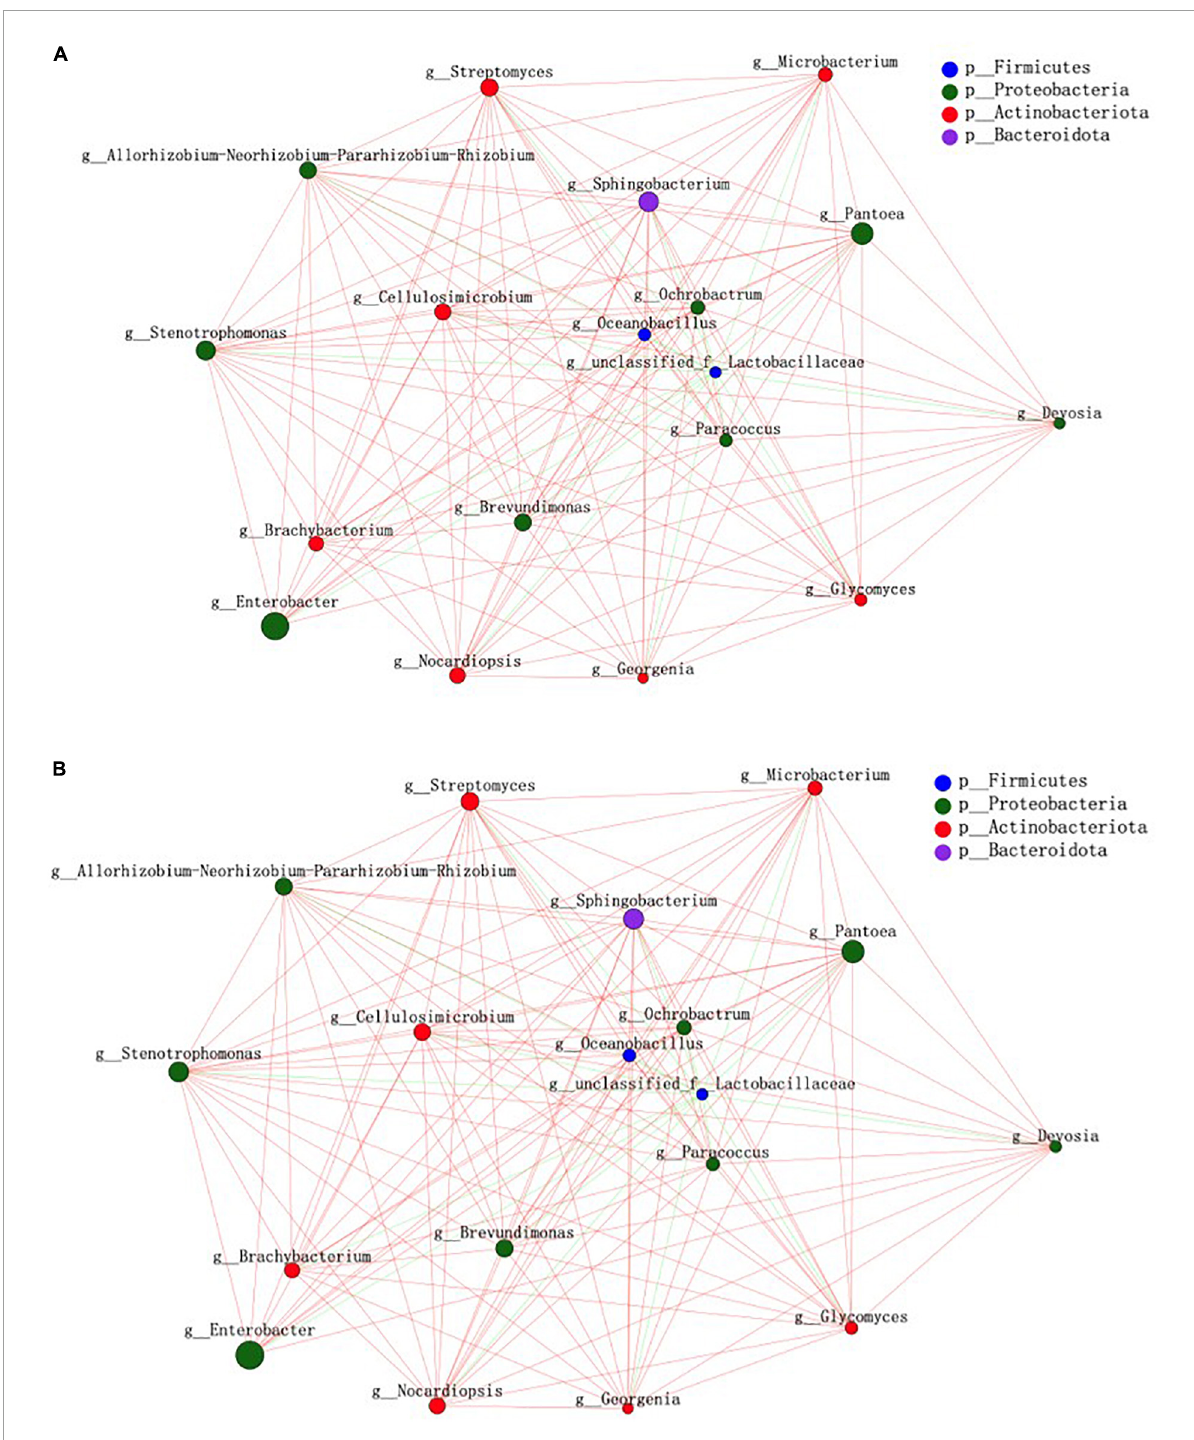
FIGURE2 Bacterial community structure in sainfoin silage. (A) Bacterial network analysis of sainfoin silage in the control. (B) Bacterial network analysis of sainfoin silage in the PEG-treated group.